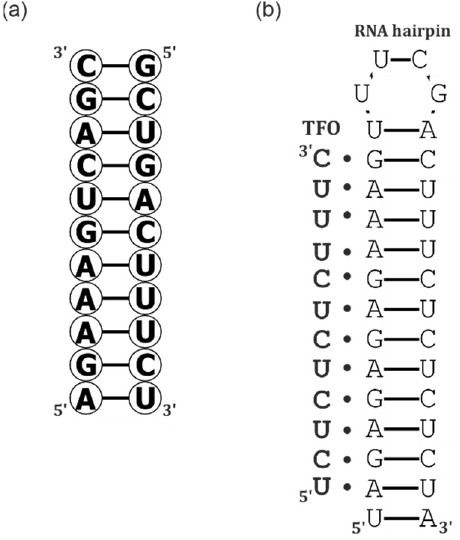
Figure 2. Examples of RNA secondary structures: ( a ) duplex and ( b ) triplex.